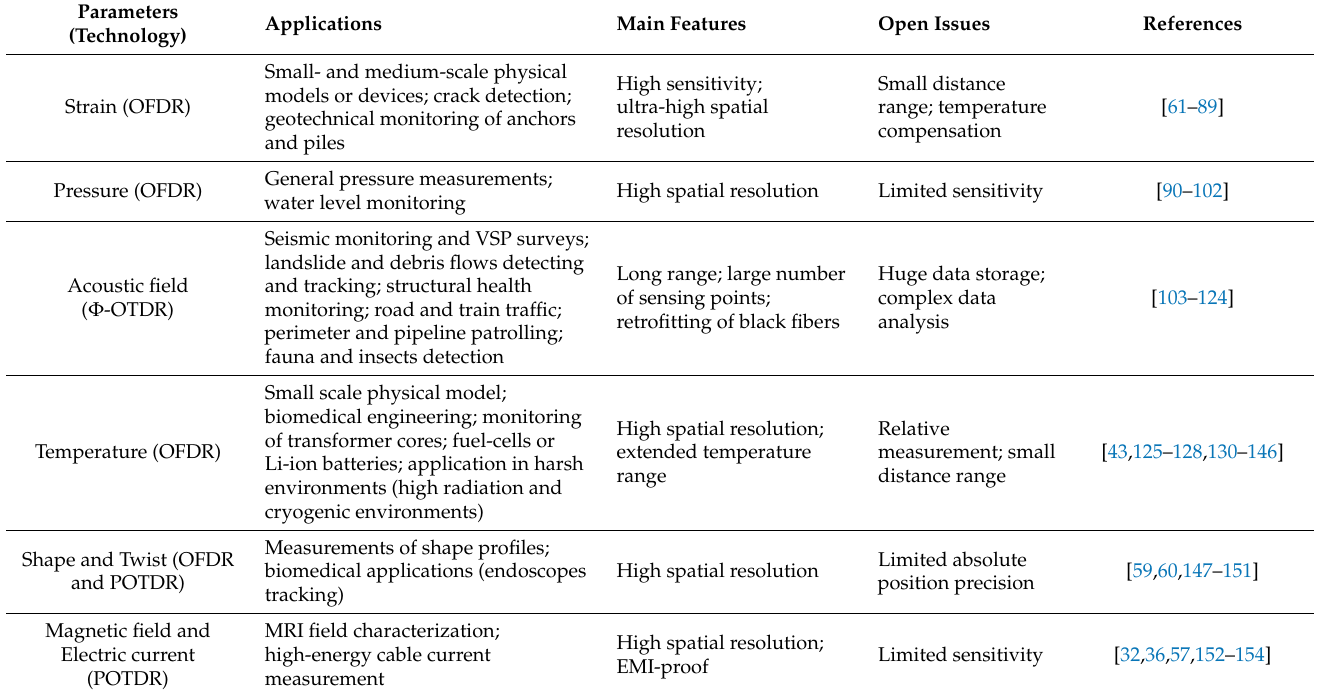
Table 1. Summary of the main Rayleigh-based DOFS applications reviewed in this